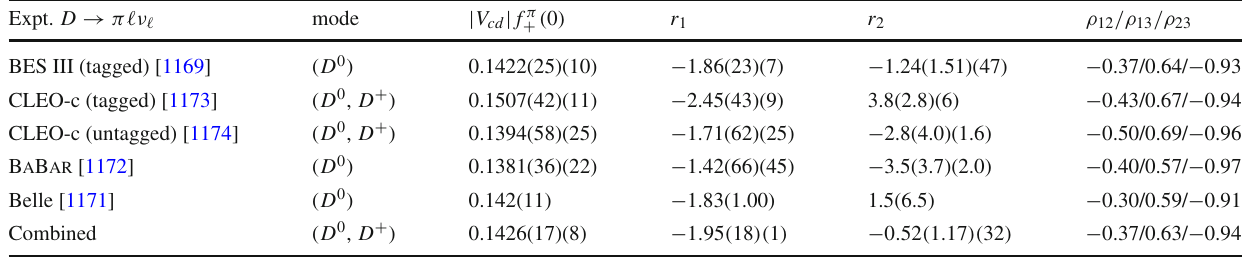
Table 278 Results of the fits to D → π(cid:12)ν (cid:12) measurements from sev- eral experiments, using the z -expansion. External inputs are updated to PDG [327]. The correlation coefficients listed in the last column refer